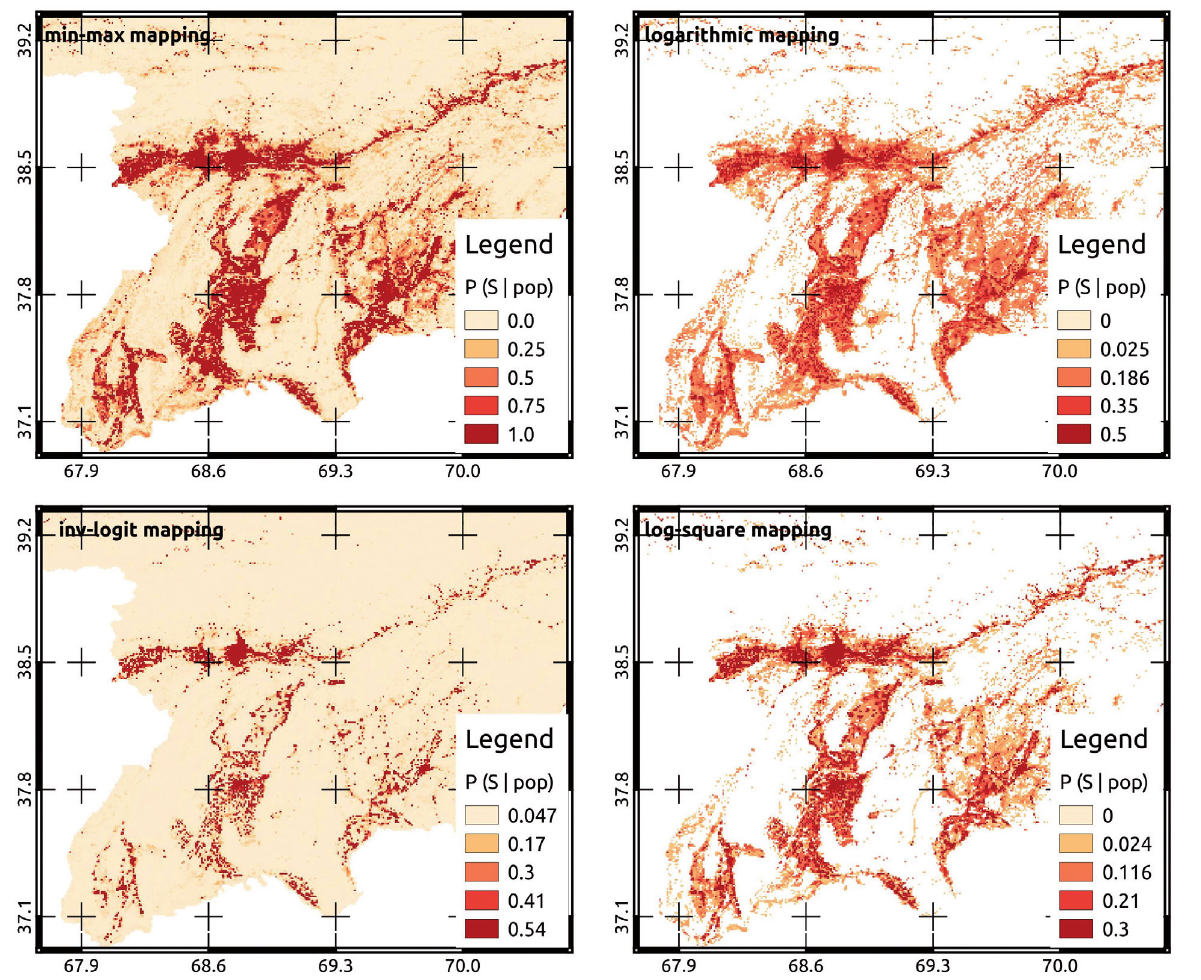
Figure 8. Comparison among different types of mapping for an indicator describing the distribution of population for a portion of the re- gion of interest. Upper left: minmax, upper right: logarithmic, lower left: inv-logit, lower right: log-square. The mapping parameters have been determined by linear regression using the sampling probability associations specified in Table 6.